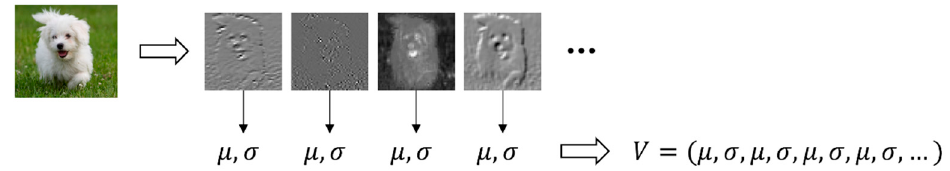
Figure 2. Feature vector extraction process. Mean and standard deviation of each feature map are calculated and listed to generate a feature vector 𝑉 .